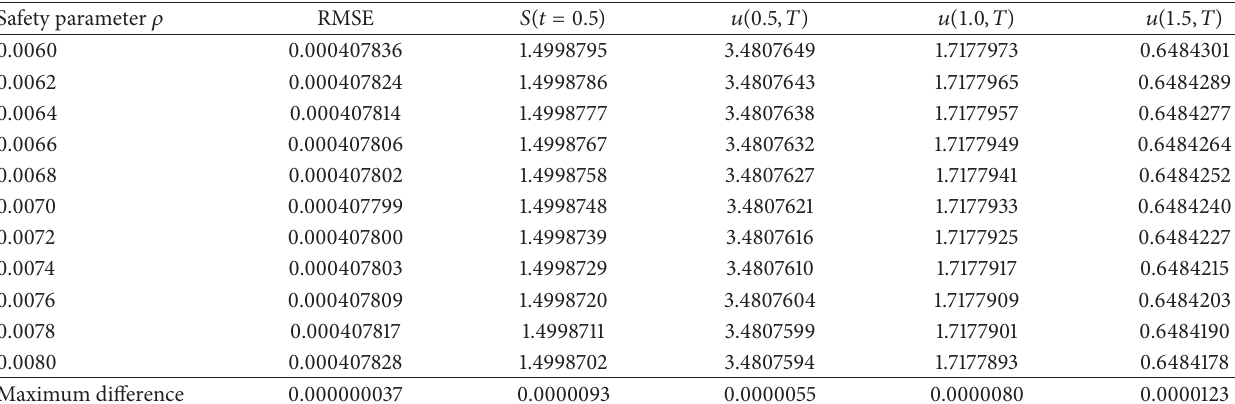
Table 1: Values in the solution.